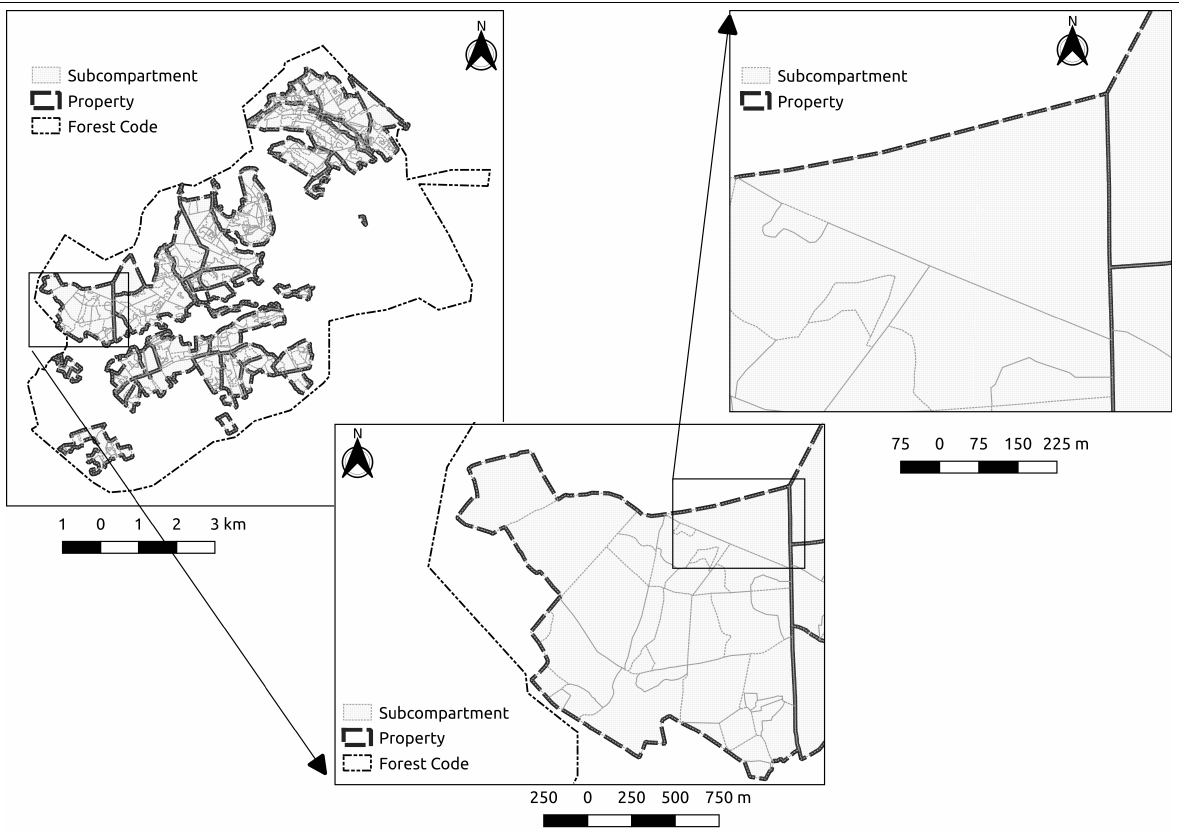
Figure 3. Illustration of the difference in scale from a forest code, property, and